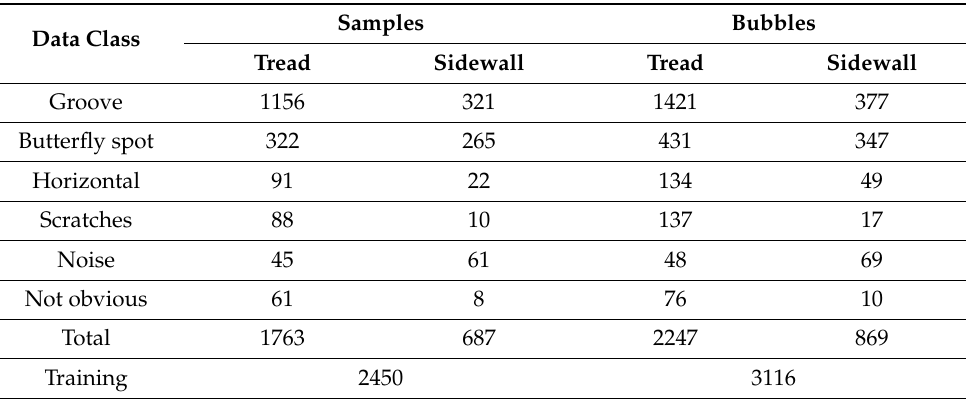
Table 1. Training Dataset.